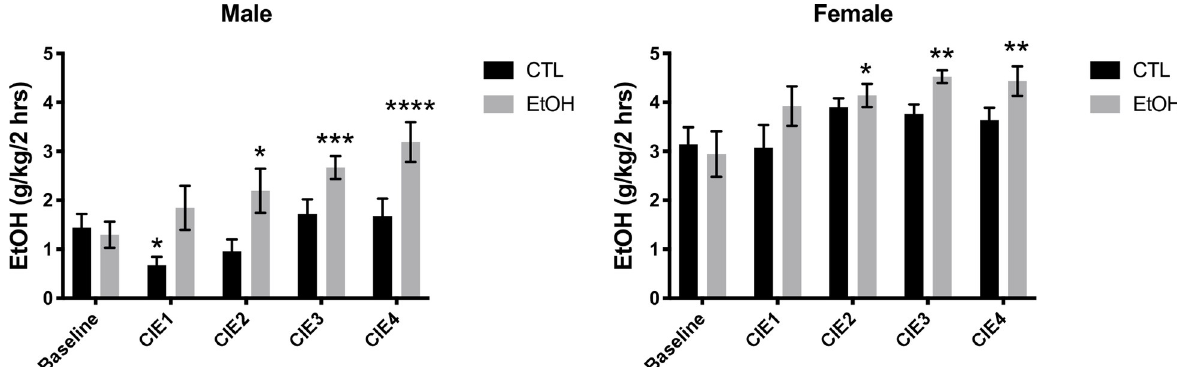
Fig 1. Effects of CIE on voluntary drinking in C57Bl/6J mice. Chronic intermittent ethanol (CIE) exposure significantly increased voluntary ethanol (15%) intake in male (but not female) mice as revealed by a two-way ANOVA. For female mice a one-way ANOVA revealed an effect of time on voluntary ethanol consumption in only the ethanol vapor group (EtOH) and not the control group (CTL). Results of Dunnett’s planned comparisons are indicated above the SEM bars. � p < 0.05, �� p < 0.01, ��� p < 0.001, and ��� p < 0.0001 vs the baseline group. Values represent mean ± SEM (n =